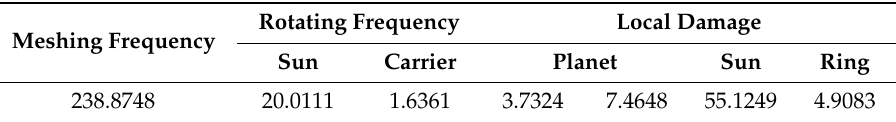
Table 4. Characteristic frequencies (Hz).